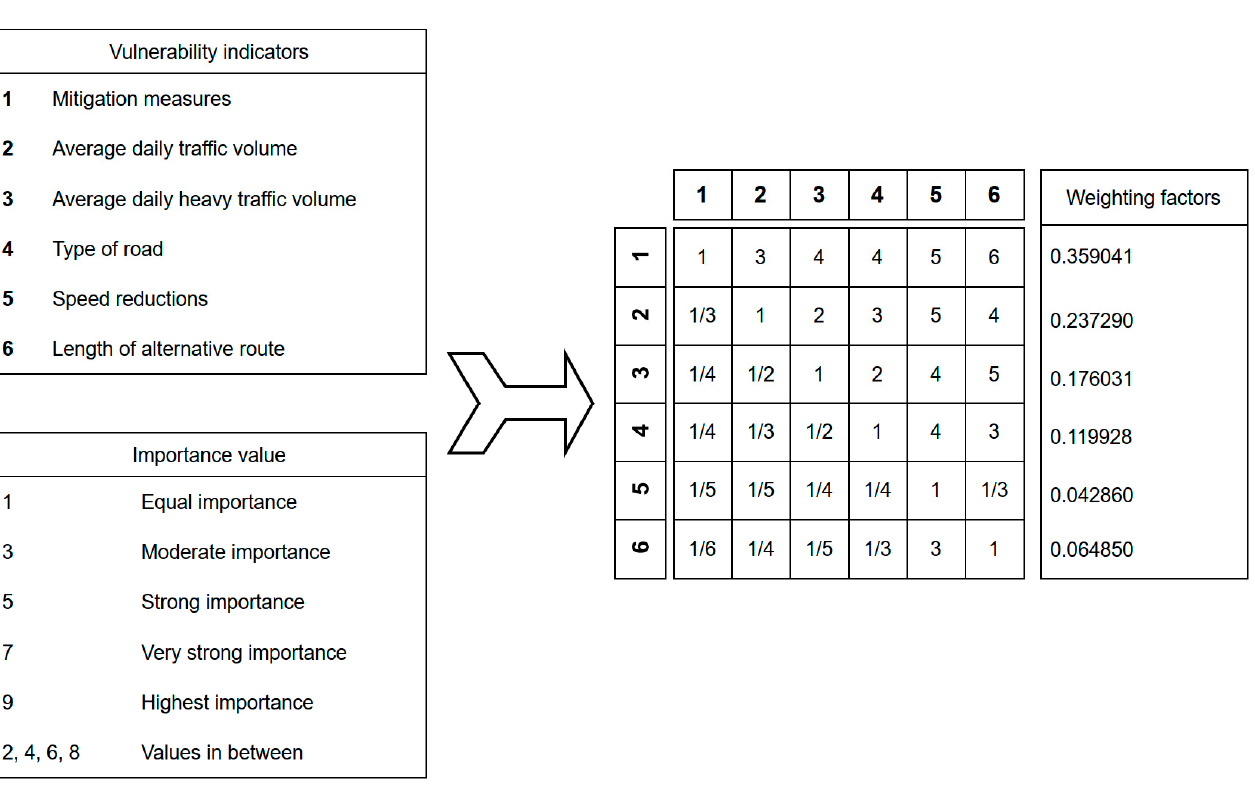
Figure 4. Vulnerability indicators and the weighting factors determined with analytical hierarchy process.